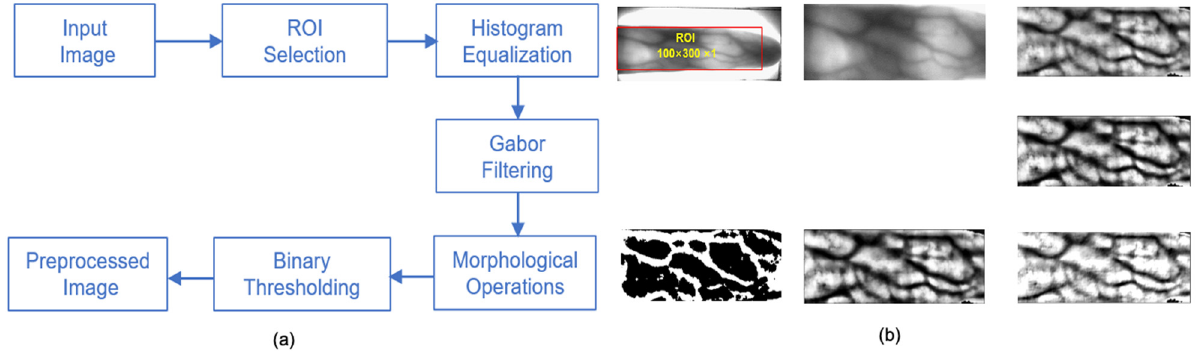
Figure 1. Data preprocessing steps. ( a ) Preprocessing block diagram, and ( b ) preprocessed images at each step in the order of preprocessing steps.